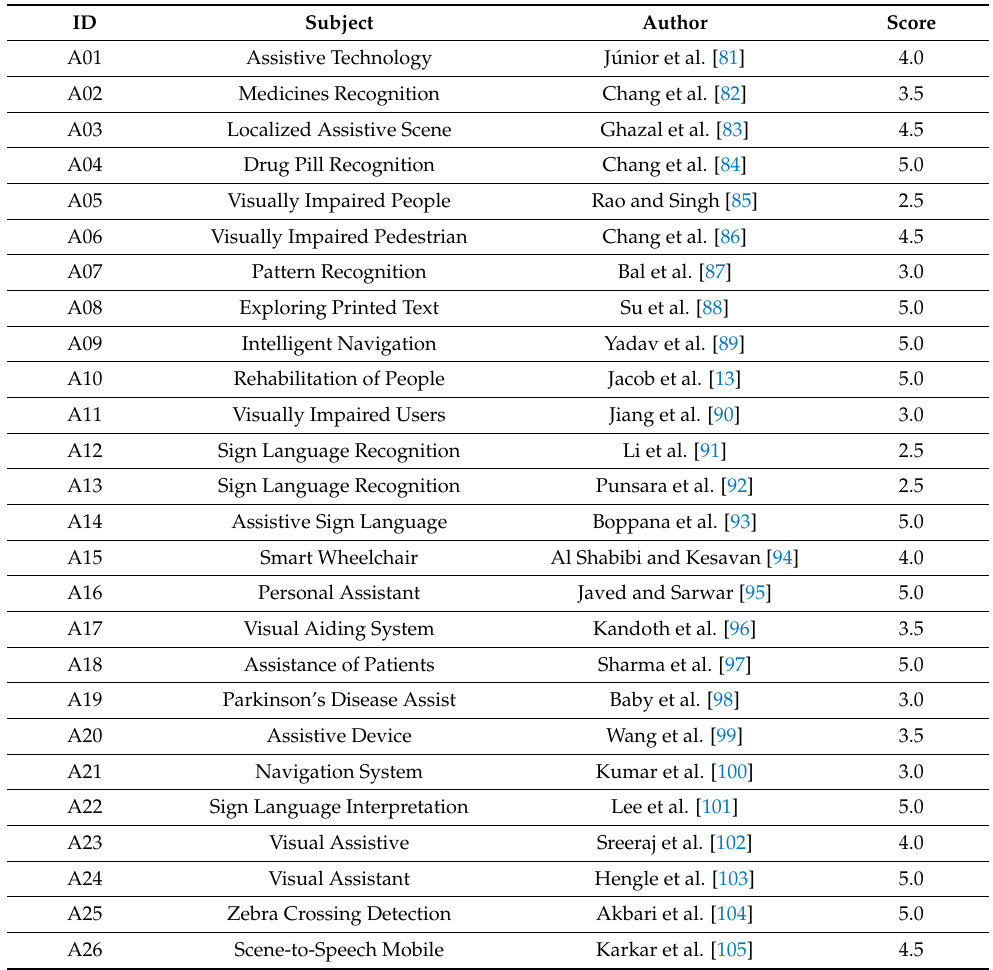
Table 7. Quality evaluation-selected